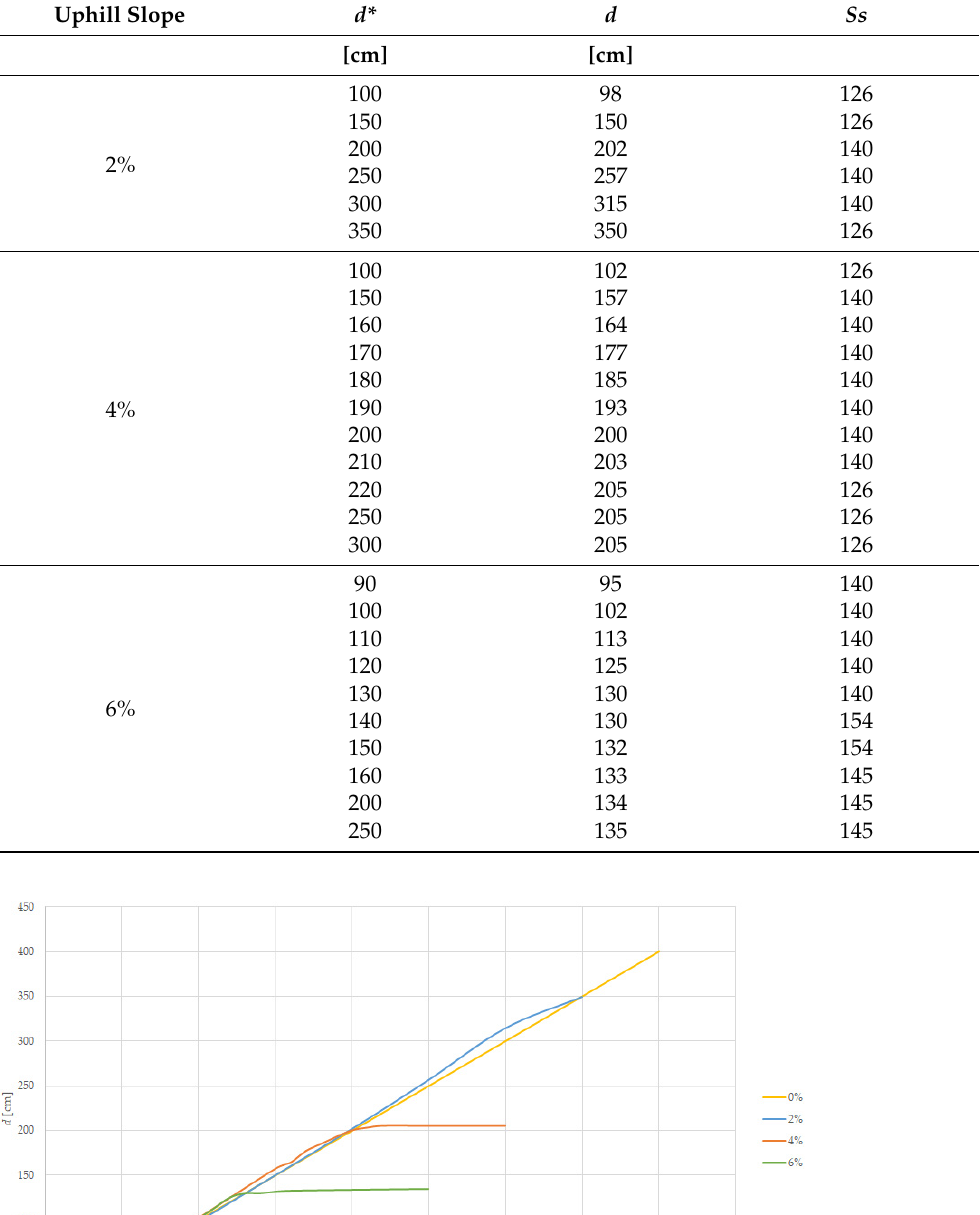
Table 5. Uphill vertical track experimental results with tramcar target on track.